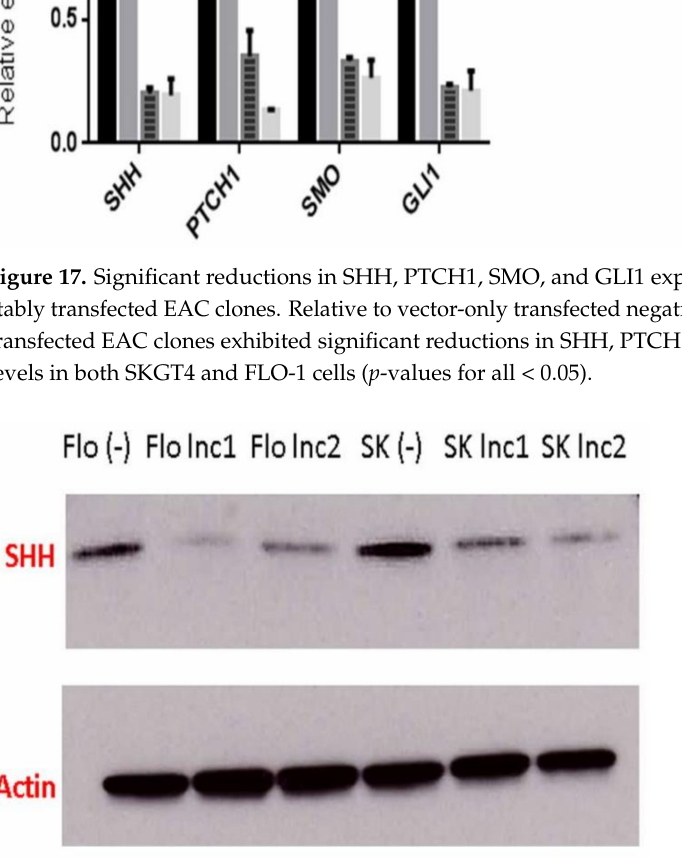
Figure 18. Significant reduction in SHH protein levels in SKGT4 and FLO-1 miR205HG-stably transfected clones. Western blotting demonstrated that SHH protein levels were greatly reduced in SKGT4 and FLO-1 miR205HG-stably transfected clones. Flo ( − ) and SK ( − ) denote FLO-1 and SKGT4 cells stably transfected with empty vector only. Flo lnc1 and lnc2 represent two different FLO-1 miR205HG stably transfected clones (the same labeling applies to SKGT4 cells). (full blots can be found in Supplementary